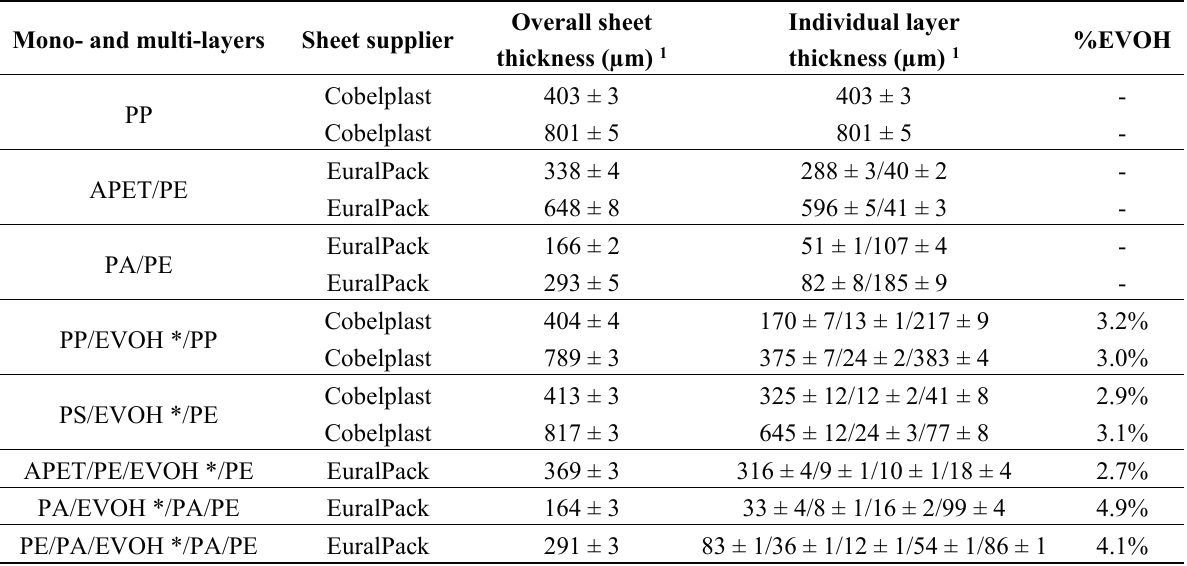
Table 1. Sheet materials: suppliers, overall and individual layer thickness, and EVOH%. Mono- and multi-layers